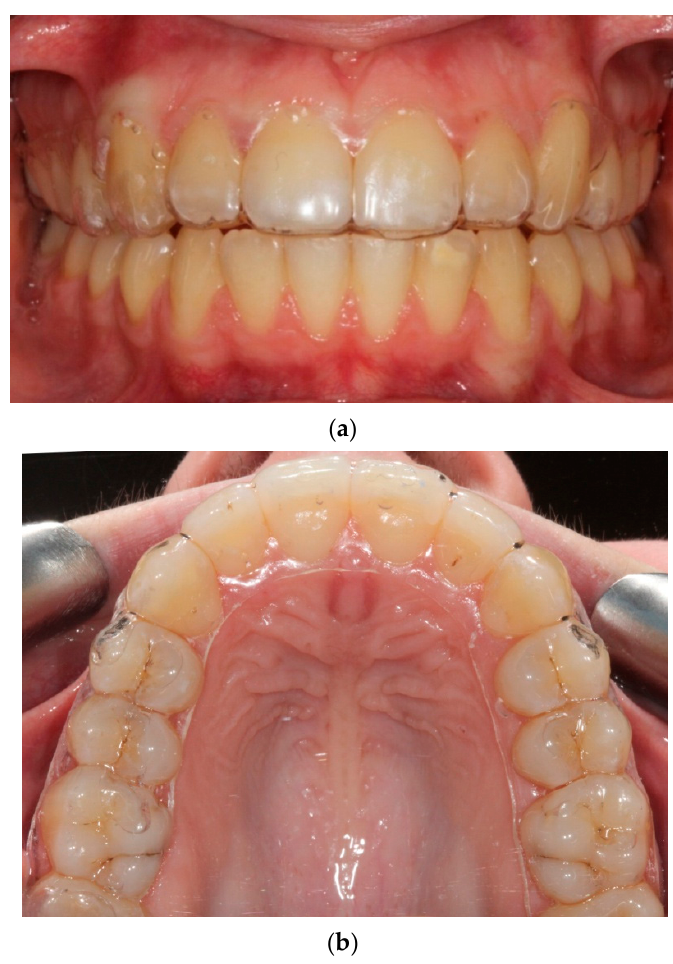
Figure 4. Vacuum-formed retainer. ( a ) Frontal view, ( b ) Occlusal view